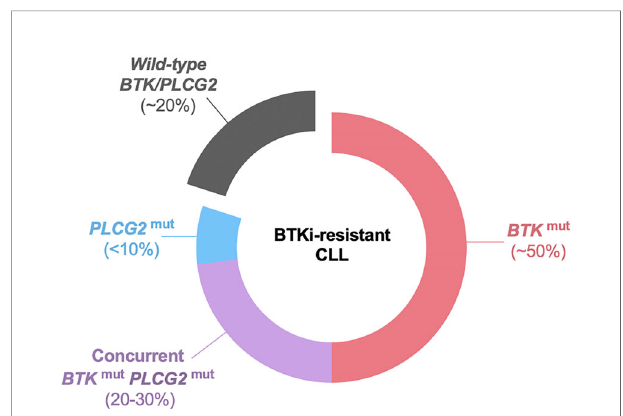
FIGURE 2 | BTK and PLCG2 mutations in BTKi-resistant CLL. Approximately 20% of patients do not have detectable BTK or PLCG2 mutation at progression. BTK mutation is the most common mutation, found in half the patients as BTK mutation alone and in an additional 20-30% with coexisting PLCG2 mutation. Less than 10% of the patients have PLCG2 mutation alone. BTKi, Bruton ’ s tyrosine kinase inhibitor; mut,